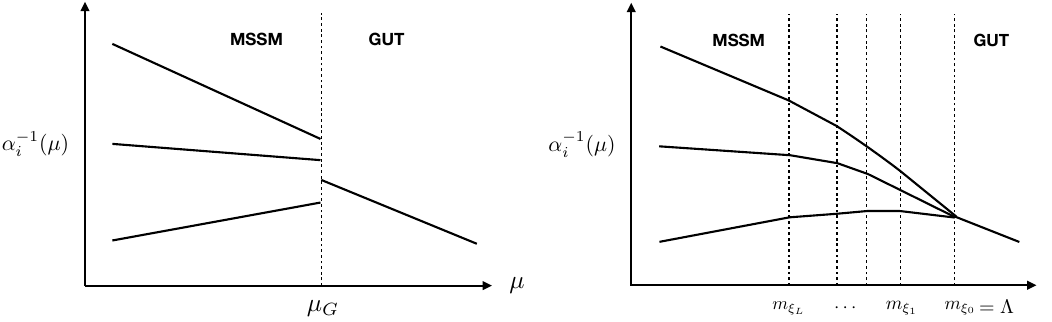
Figure 4 . The RGE evolution of the gauge couplings in two di(cid:11)erent pictures: Left: a single EFT matching (from GUT to MSSM) at (cid:22) G . Right: sequential EFT matchings at the particle masses. Here, the uni(cid:12)cation scale, (cid:3), is given by the mass of the heaviest particle, m (cid:24) incomplete GUT